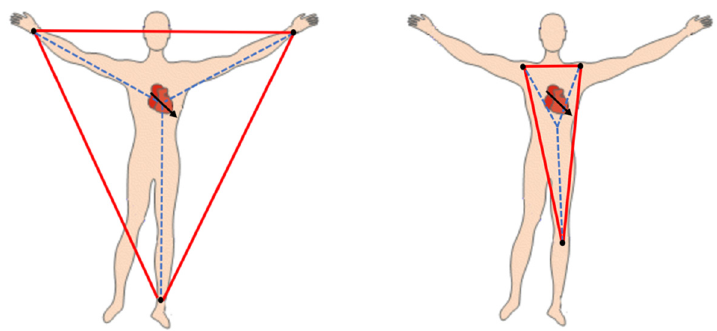
Figure 8. The measured WCT depends on the limb electrodes’ position. The WCT amplitude and location vary by changing the electrodes placed on the limbs.